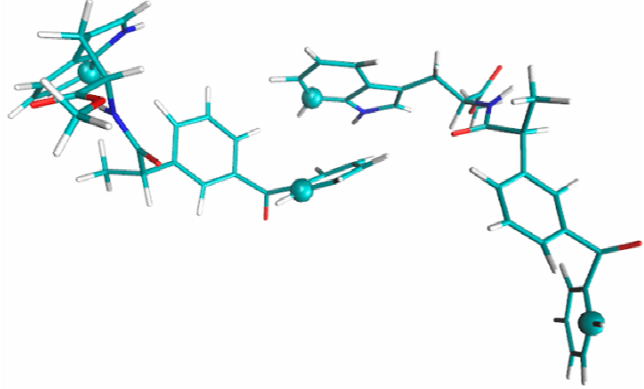
Figure 5. Example of dimer structures for ( R,S )-IV. The spheres mark the atoms, the distance between which was taken for analysis.